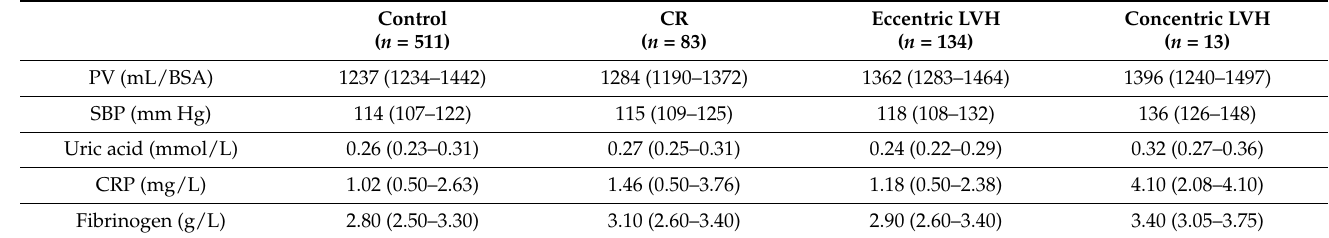
Table 3. Data are given as median (interquartile range) of the marker variables in 752 formerly preeclamptic women with normal geometry (control), eccentric LVH, and concentric LVH 6 months to 5 years postpartum. Untransformed marker data were used to calculate median (interquartile range). Transformed marker data were used to compare groups to control using ANCOVA.